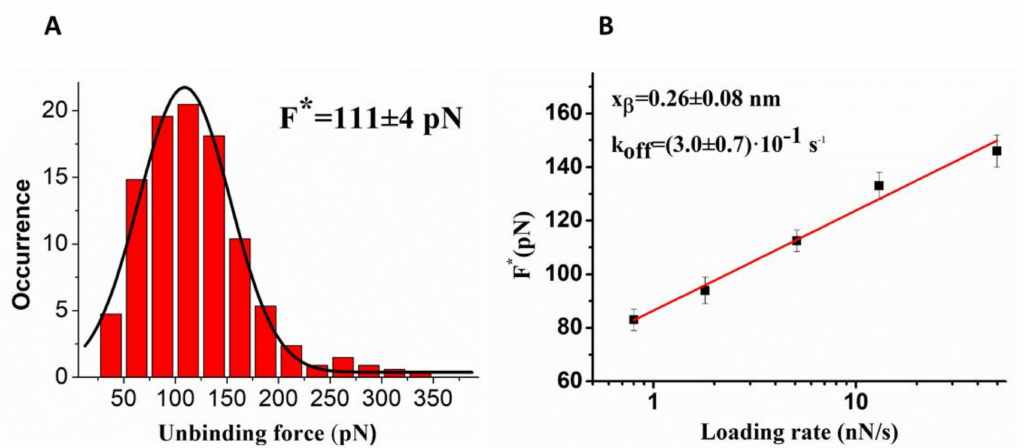
Figure 2. ( A ) Histogram of the unbinding forces for the HSA/miR4749 complex from AFS measure- ments carried out at a loading rate of 5 nN/s. The most probable unbinding force value (F*) was determined from the maximum of the main peak of the histogram by fitting with a Gaussian function (black curve). ( B ) Plot of the most probable unbinding force, F*, vs. the logarithm of the loading rate for the HSA/miR4749 complex. Red continuous line is the best fit by the Bell–Evans model (Equation (5)); the extracted values for the k off and x β parameters are